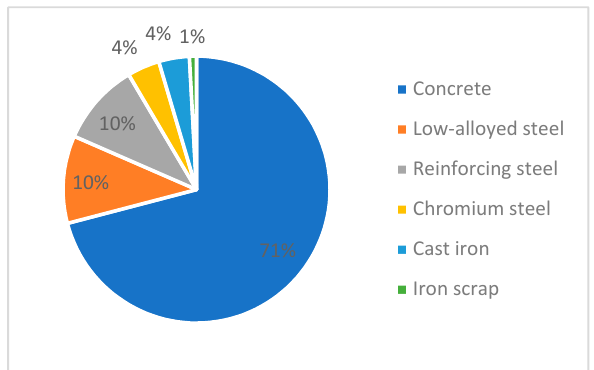
Figure 4. Material quantities for the LCA study not including prefabricated components.